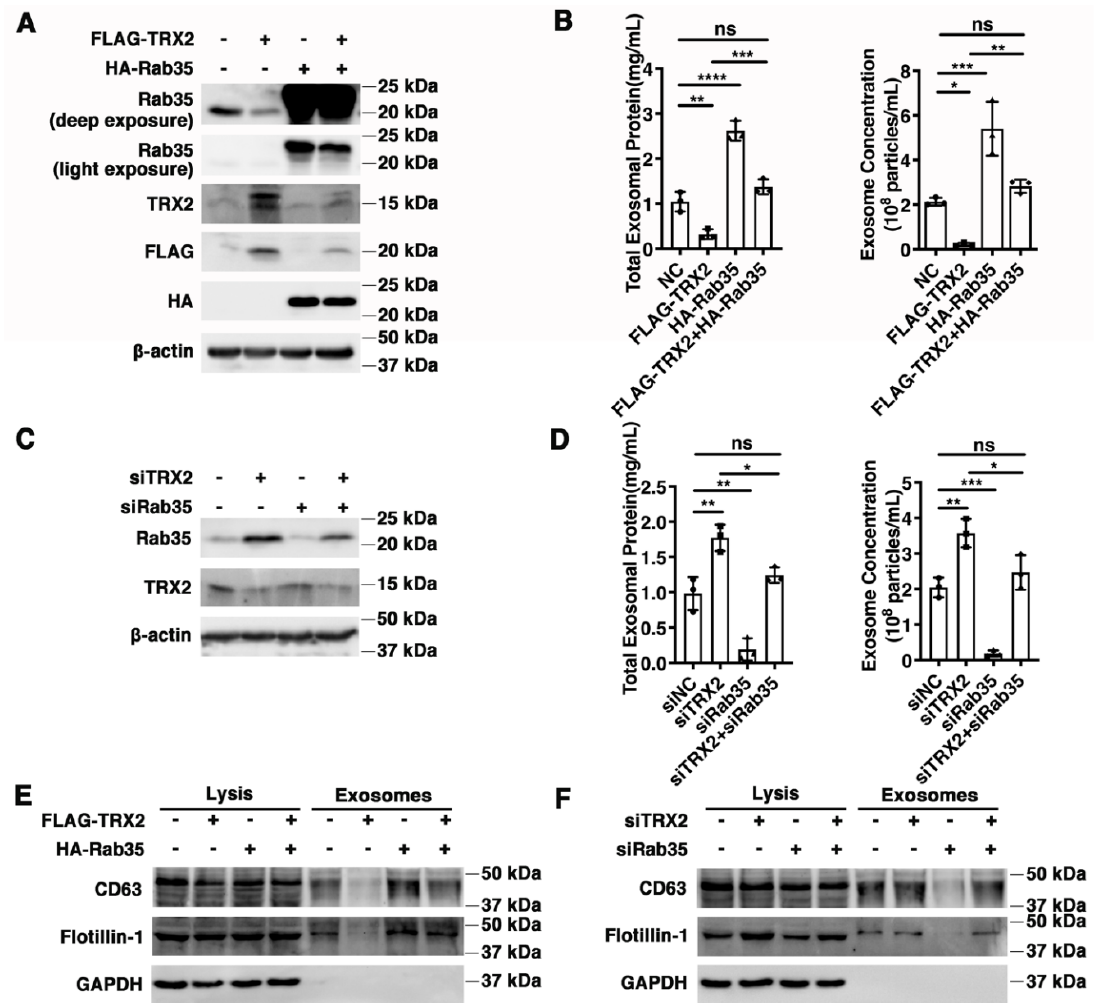
Figure 5. TRX2 impaired exosome secretion through Rab35 degradation. ( A ) HCT116 cells were transfected with pcDNA3.1+, FLAG − TRX2, or HA − Rab35. The indicated proteins were detected by WB. ( B ) HCT116 cells were transfected with pcDNA3.1+, FLAG − TRX2, or HA − Rab35. The EVs were isolated from the 10 mL cell culture supernatants of 25 million cells by serial ultracentrifugation and resuspended in 100 μL PBS. The total exosomal protein and exosome concentrations were measured. ( C ) HCT116 cells were transfected with siNC, siTRX2, or siRab35. The indicated proteins were detected by WB. ( D ) HCT116 cells were transfected with siNC, siTRX2, or siRab35. The EVs were isolated from the 10 mL cell culture supernatants of 25million cells by serial ultracentrifugation and resuspended in 100 μL PBS. The total exosomal protein and exosome concentrations were measured. ( E ) HCT116 cells were transfected with pcDNA3.1+, FLAG − TRX2, or HA − Rab35, and the exosomes were purified. The biomarkers of the exosomes were detected by WB in whole cell lysates (20 μg) and exosomes (20 μL). ( F ) HCT116 cells were transfected with siNC, siTRX2, or siRab35, and the exosomes were purified. The biomarkers of the exosomes were detected by WB in whole cell lysates (20 μg) and exosomes (20 μL). The experiments were performed for three biological replicates. The error bars represent means ± SD. ns, no significant difference; * p < 0.05, ** p < 0.01, *** p < 0.001, and **** p < 0.0001 using one −way ANOVA with Šídák’s multiple comparisons test.